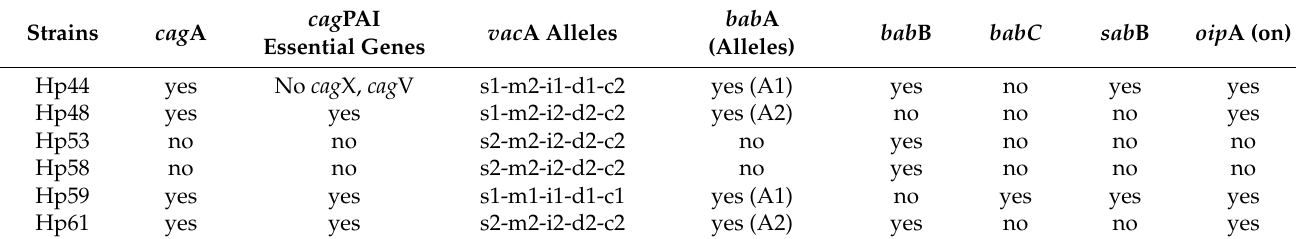
Table 2. Virulence markers of H. pylori strains isolated from gastric